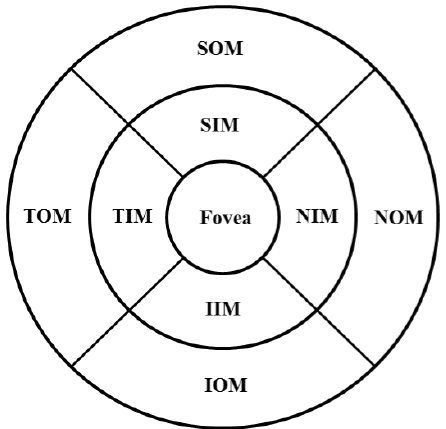
Fig. 4. Segmentation of superior, inferior, nasal, and temporal quadrants. Fovea: the central fovea, NIM: nasal inner macula, SIM: superior inner macula, TIM: temporal inner macula, IIM: inferior inner macula, NOM: nasal outer macula, SOM: superior outer macula, TOM: temporal outer macula, IOM: inferior outer